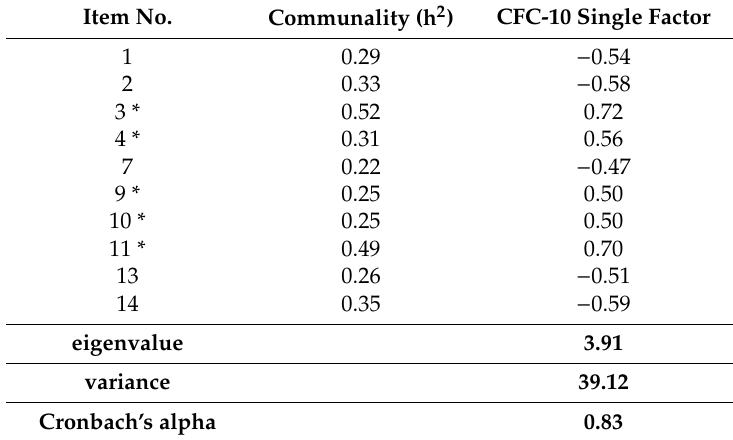
Table 4. EFA single-factor solution: communalities and factor loadings of the CFC-10 items. Item No. Communality (h 2 )